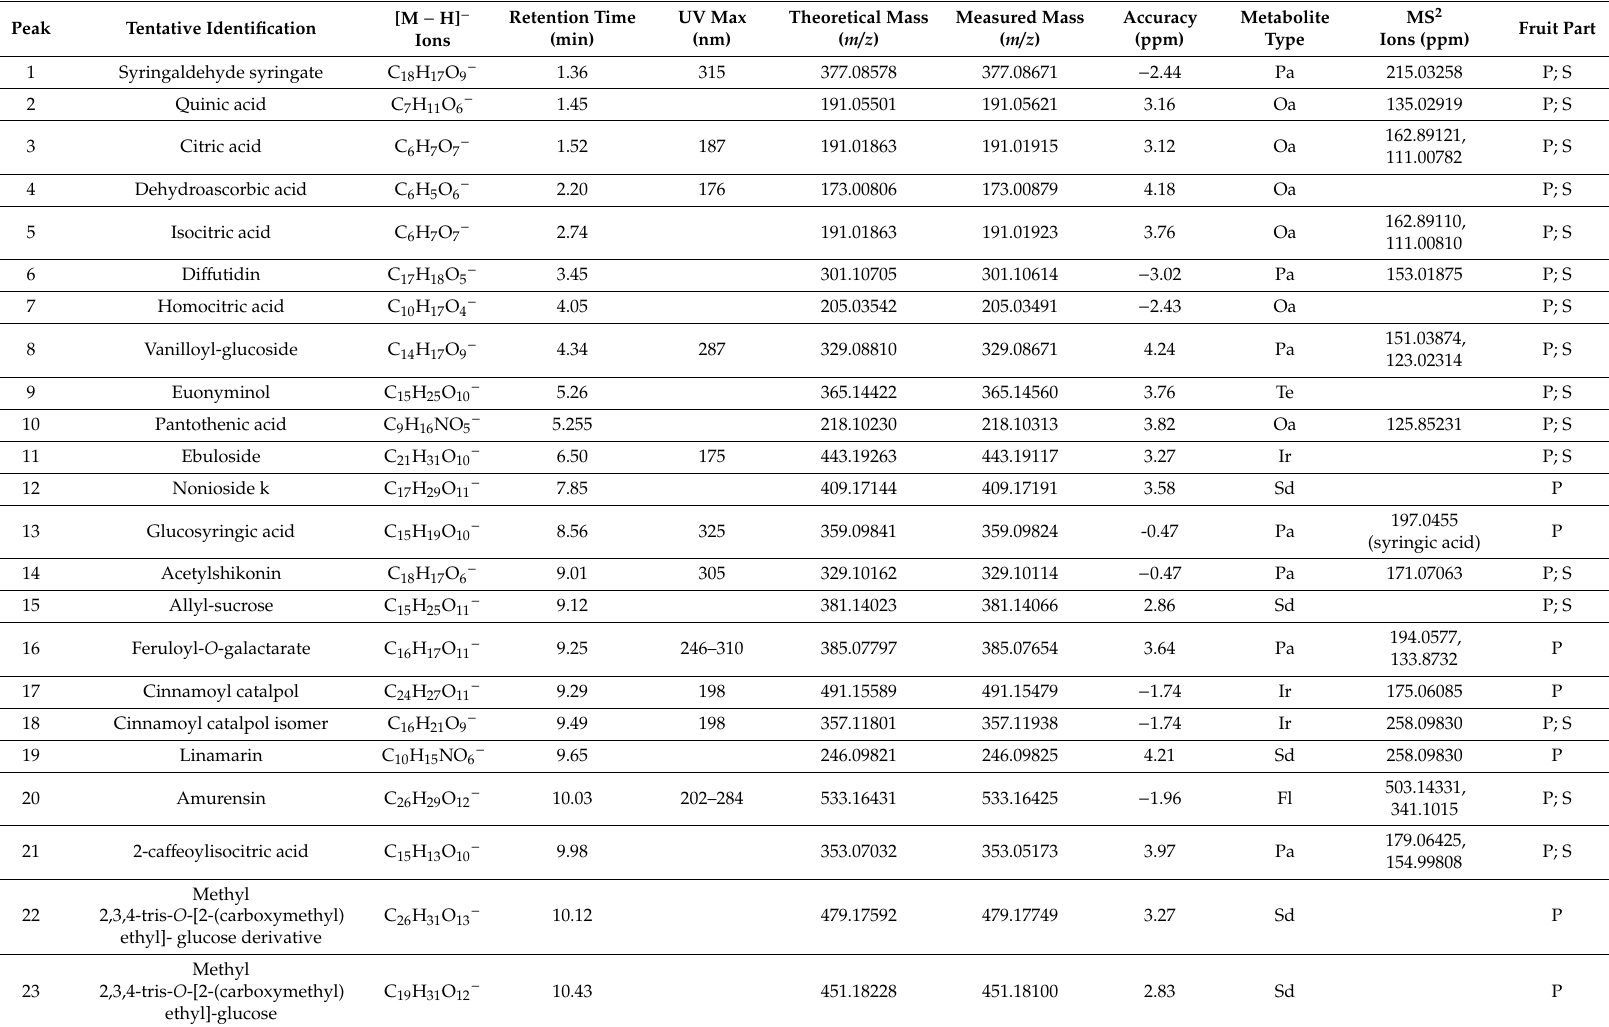
Table 1. Full metabolome identification in Greigia sphacelata by